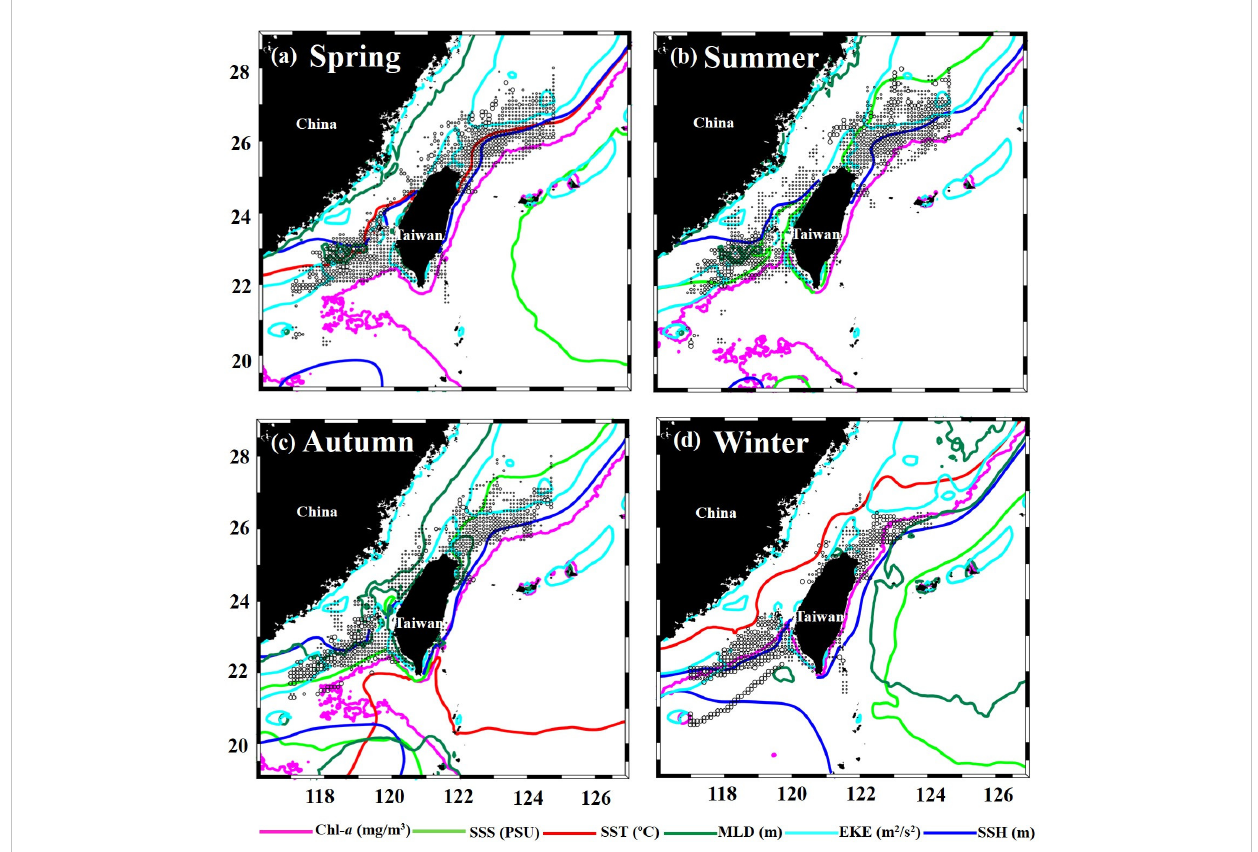
FIGURE 11 Seasonal spatial distribution of greater amberjack fi sheries with most preferred environmental conditions indicated with colored lines; magenta (Chlorophyll- a ; Chl- a ), light green (sea surface salinity; SSS), red (sea surface temperature; SST), dark green (mixed layer depth; MLD), aqua blue (eddy kinetic energy; EKE), blue (sea surface height; SSH),